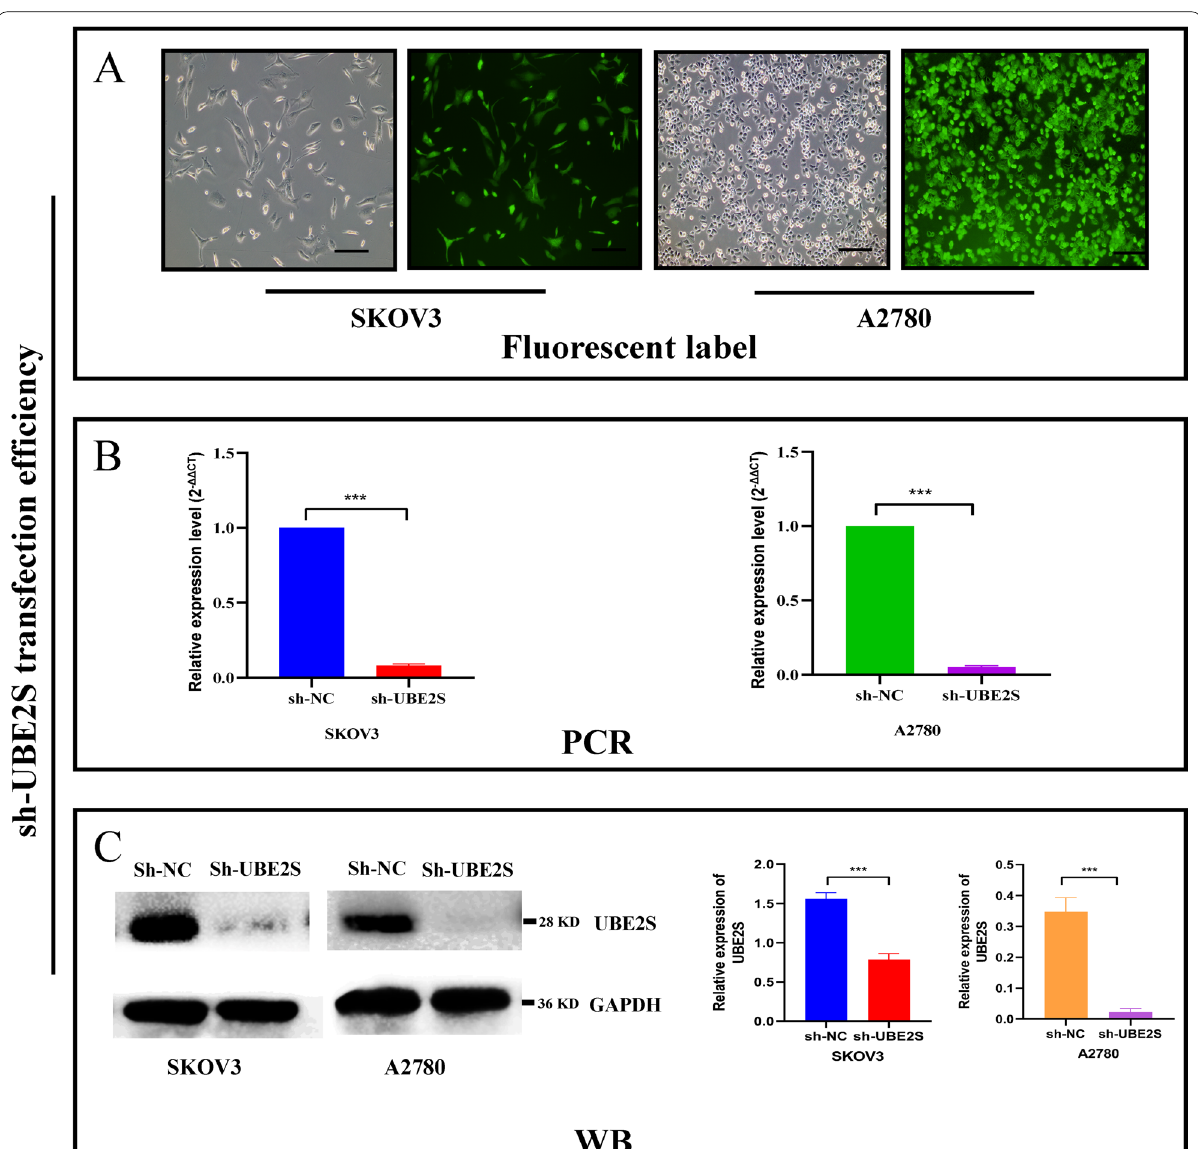
Fig. 6 The knockdown efficiency of sh-UBE2S in OV cells base on immunofluorescence and Western blotting. A The transfection efficiency of sh-UBE2S evaluated by the non-fluorescence channel and the green fluorescence channel of the fluorescence microscope. The cells under the non-fluorescent channel represent the total live cells. The cells under the green fluorescence channel represent live cells that have been successfully transfected. B RT-qPCR after cell transfection. C Western blot image and corresponding statistics after cell transfection. (*P < 0.05, **P < 0.01, ***P <